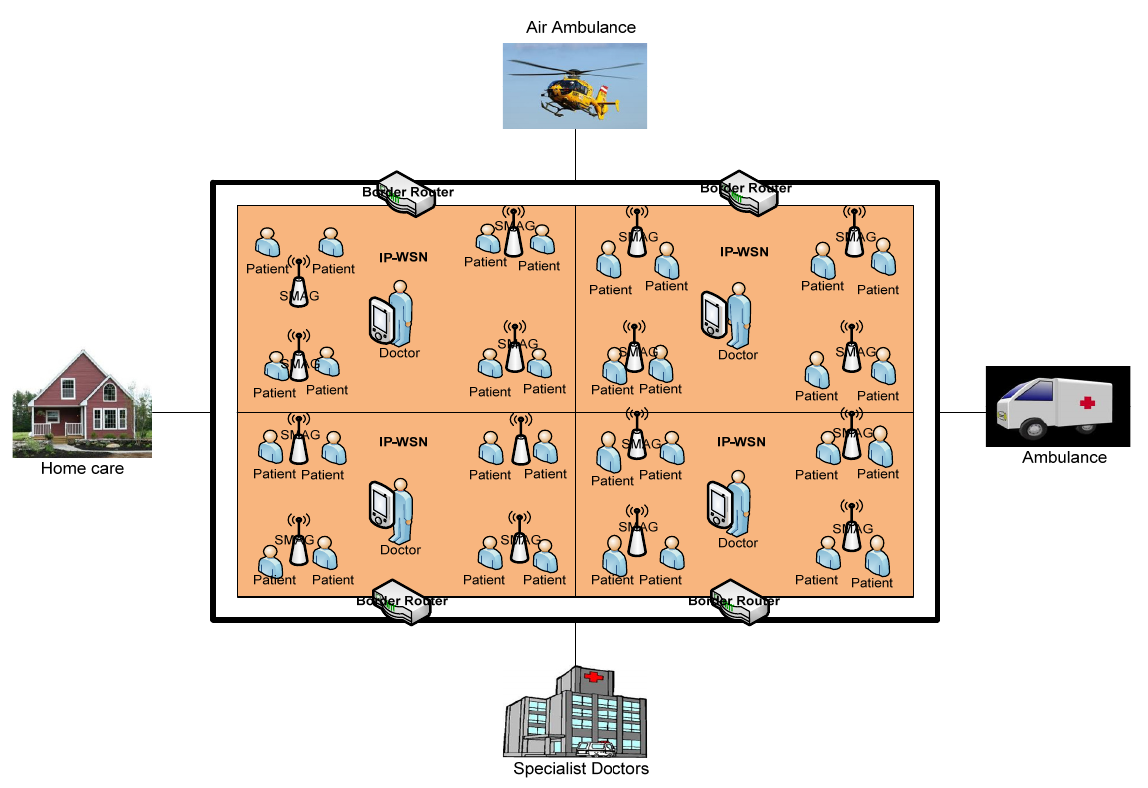
Figure 3. Global IP-WSN based patient care